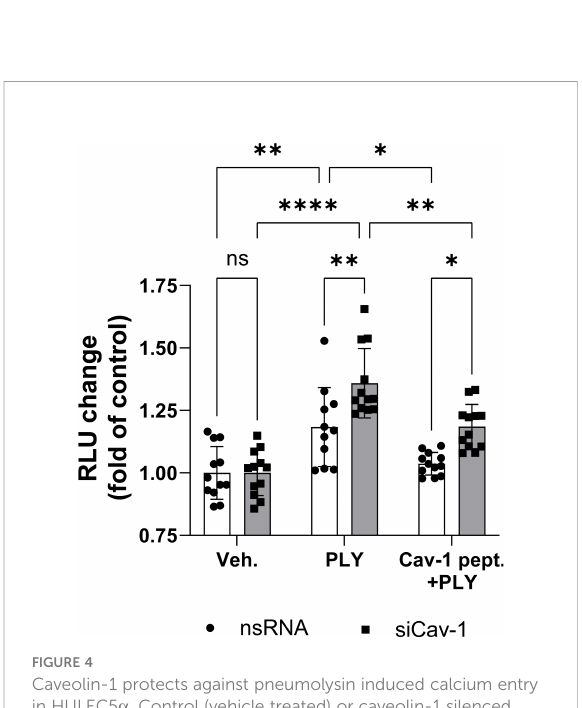
FIGURE 4 Caveolin-1 protects against pneumolysin induced calcium entry in HULEC5 a . Control (vehicle treated) or caveolin-1 silenced HULEC5 a cells were treated with PLY (60 ng/mL) for 10 minutes and calcium in fl ux was detected by Fluo-4-mediated fl uorescent intensity (n=11-12). ns, not signi fi cant, *P<0.05,